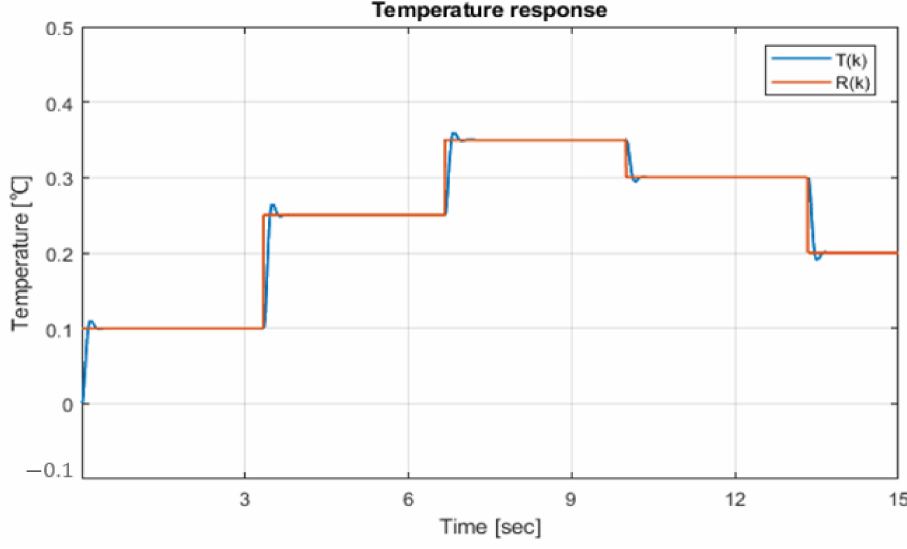
Figure 9. GHE output temperature T ( k ) tracing the reference temperature trajectory R ( K ) by MPC.